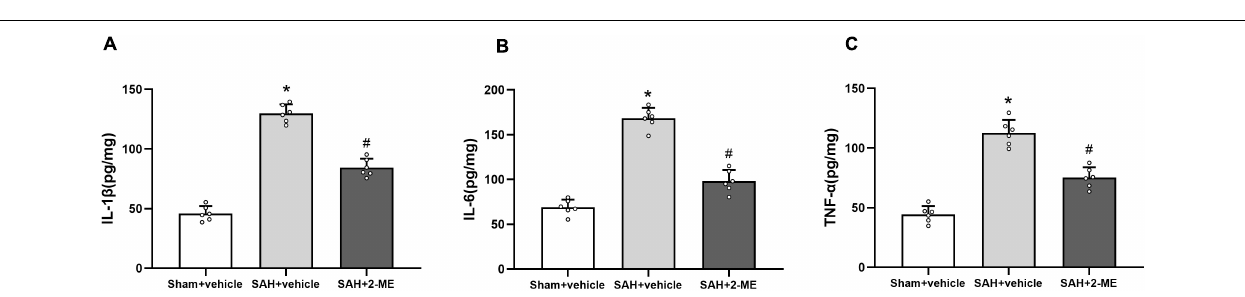
FIGURE 3 | Effect of 2-ME on the expression of IL-1 β , IL-6, and TNF- α . Enzyme linked immunosorbent assay for the expression of IL-1 β (A) , IL-6 (B) , and TNF- α (C) in the ipsilateral basal cortex in different groups at 24 h after SAH induction. Data are shown as mean ± SD ( n = 6 per group). * P < 0.05 vs. the Sham + vehicle group; # P < 0.05 vs. the SAH + vehicle